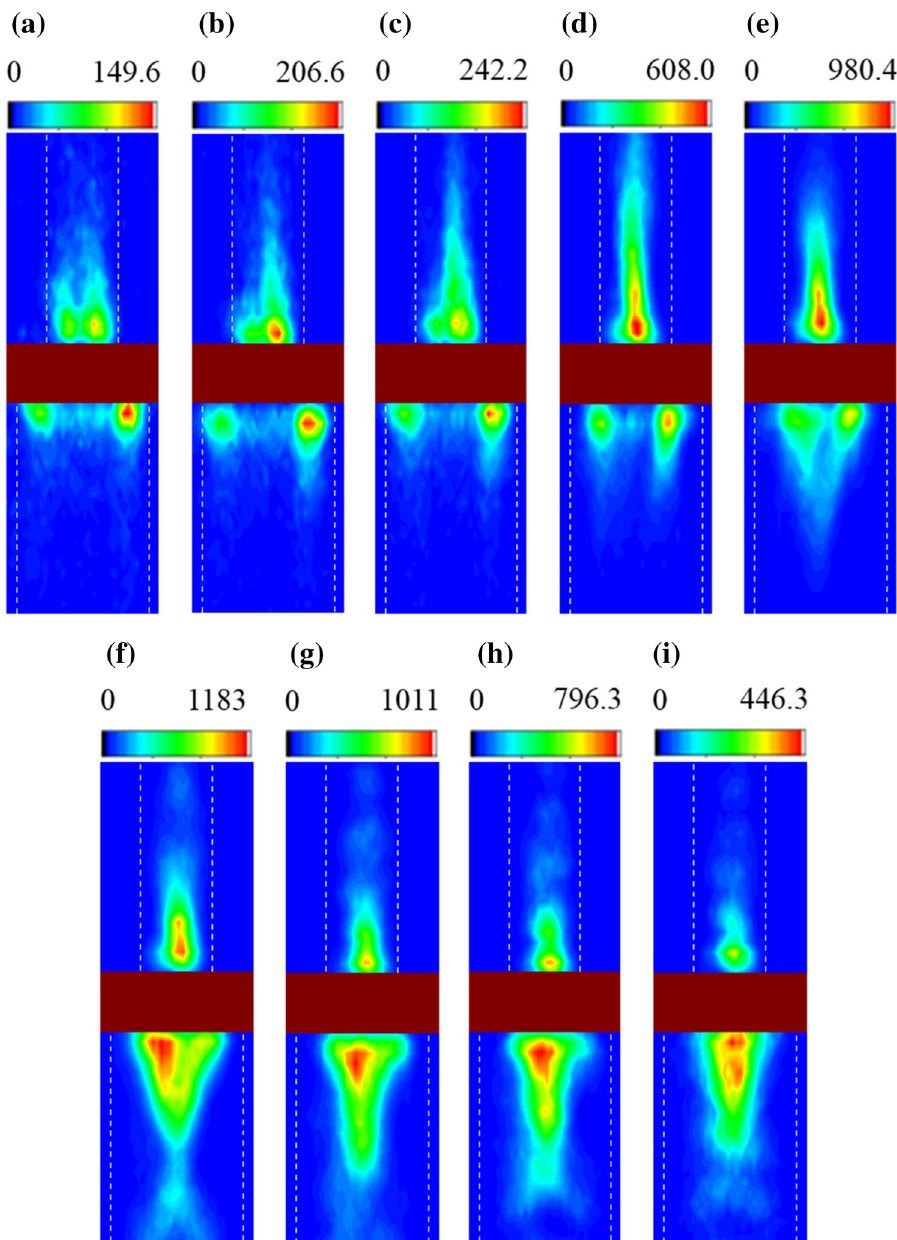
Figure 3. Spatial profiles of Brillouin light spectrum with various RF frequencies in the two blocks: ( a ) 7.6 GHz ( b ) 7.8 GHz ( c ) 7.9 GHz ( d ) 8.2 GHz ( e ) 8.4 GHz ( f ) 8.8 GHz ( g ) 9.0 GHz ( h ) 9.2 GHz and ( i ) 9.4